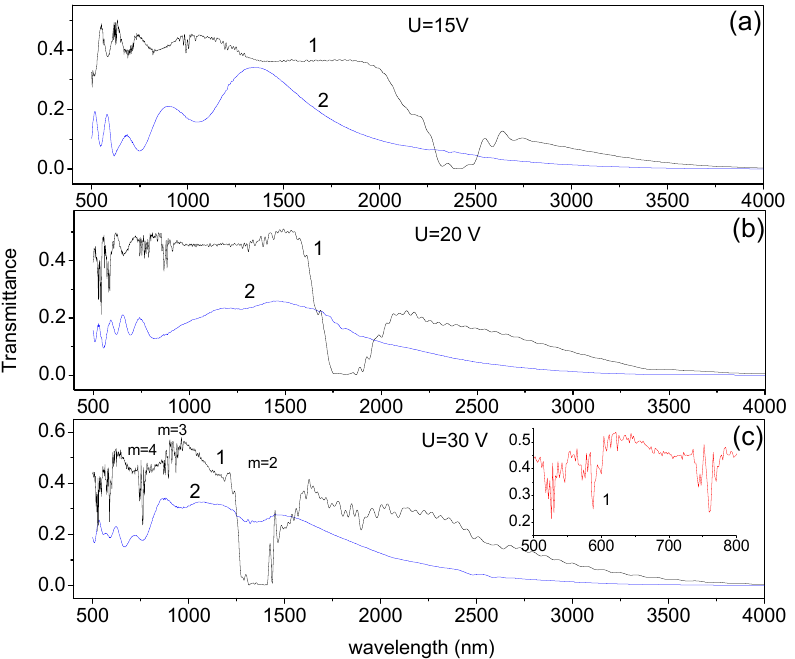
Figure 10. ( a – c ) Transmittance spectra for the z- (1) and y -polarized (2) components of the light at different voltages U . The inset in ( c ) shows a fraction of the same spectrum in visible range with a higher spectral resolution.